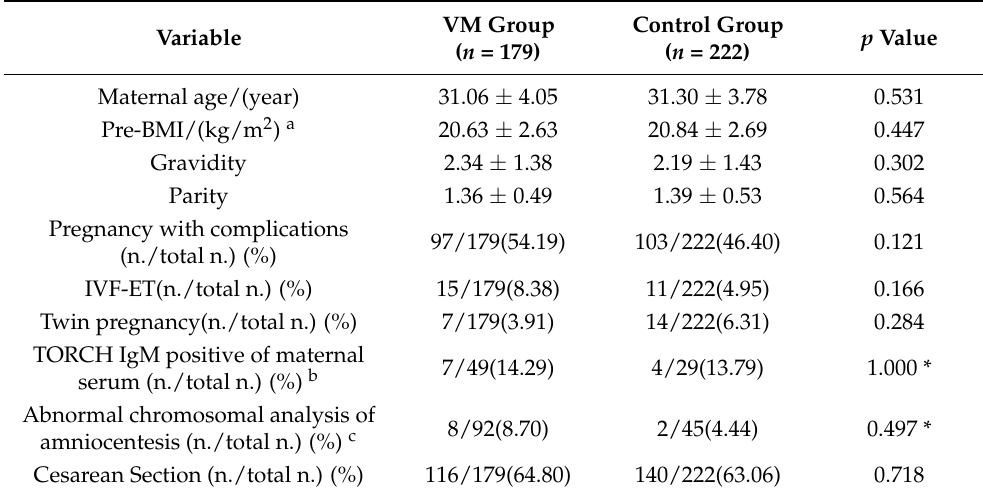
Table 1. General conditions of VM group and control group.